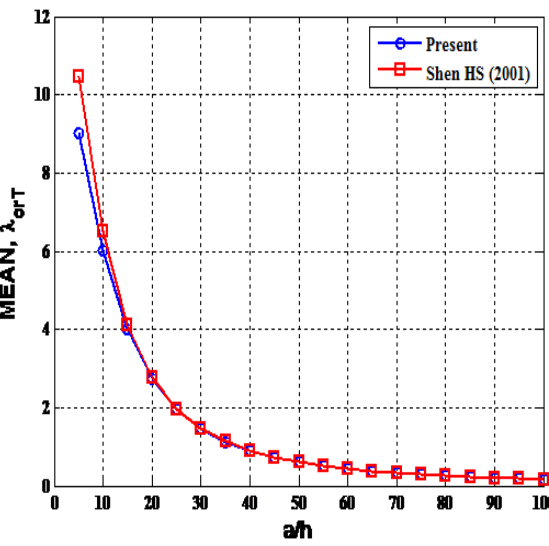
Figure 3: Comparison study for mean buckling temperature of angle- ply laminated [(45/-45) 3 ] S square composite plate subjected to uniform temperature.